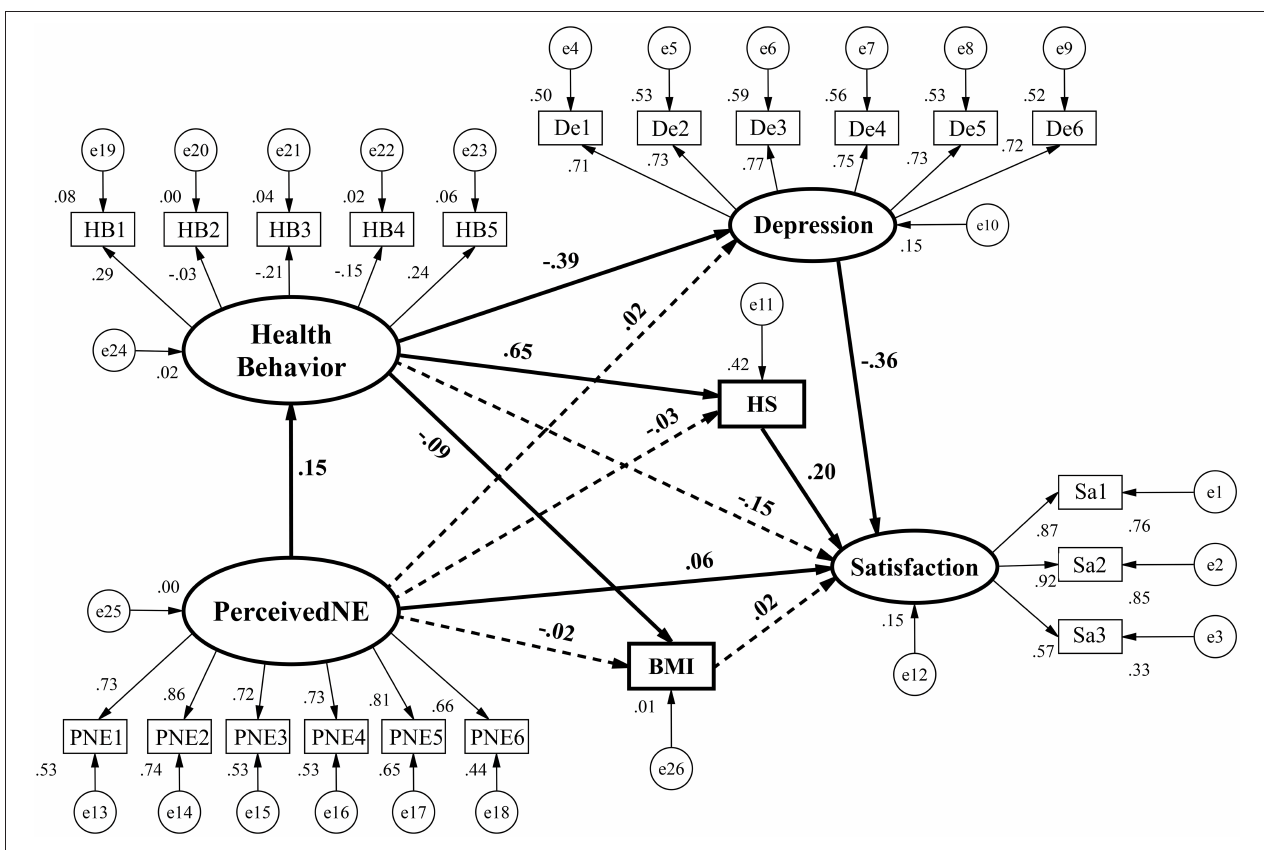
FIGURE 3 | Path diagram of the default model (Full lines indicate weights that are statistically significant at 5% level; otherwise, dash